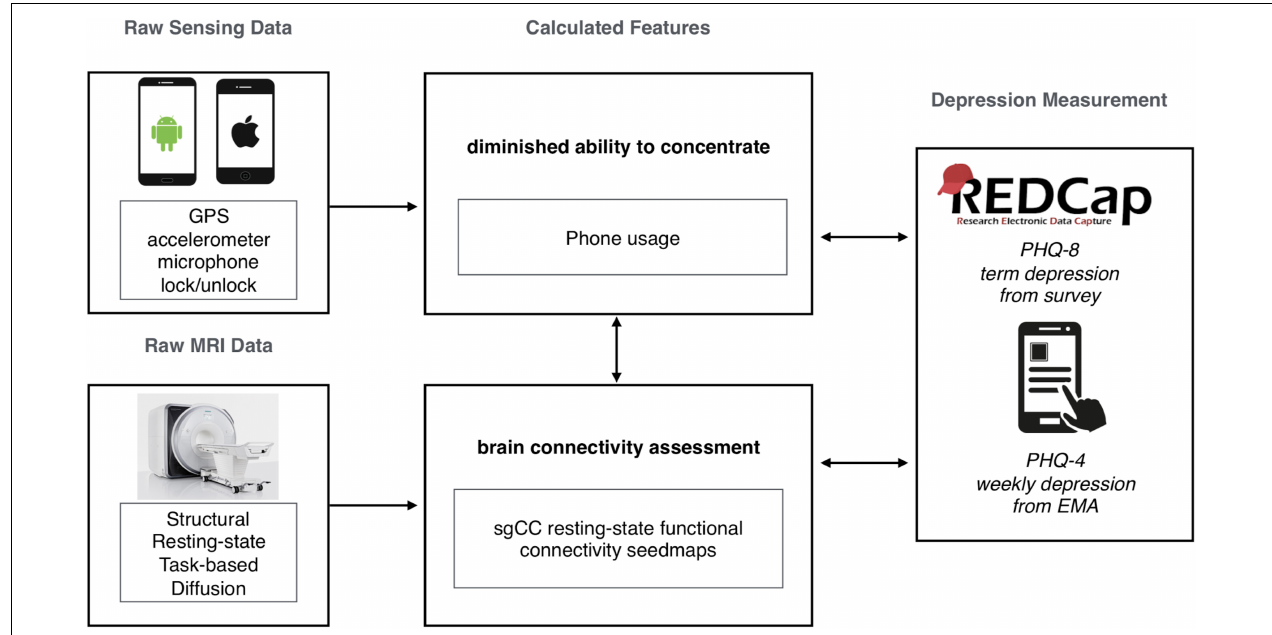
FIGURE 1 | Summary graphic of the study workflow in the current study, showing raw data collection from both smartphones (StudentLife, passive sensing) and MRI (resting-state functional connectivity, sgCC seed-based analysis). Calculated features were selected based on previous research. Survey data was collected with both online (REDCap, PHQ-8) and smartphone (StudentLife, Ecological Momentary Assessments, PHQ-2/4)